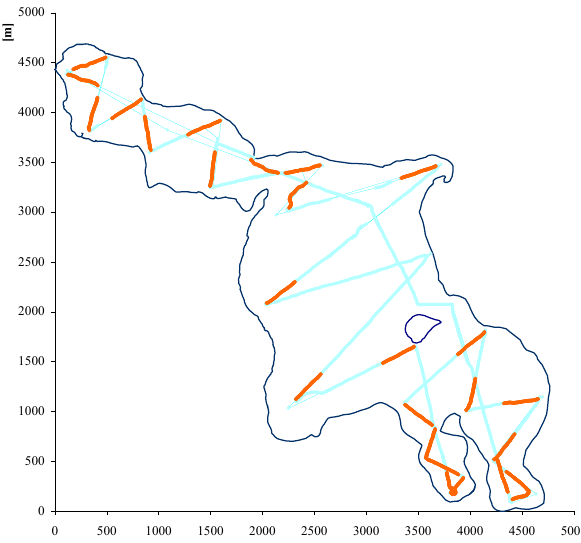
Figure 2. Location map of hydroacoustic survey transects (solid light blue line) in Lake Dejguny (Poland) during September/October 2021. The solid orange line marks the initial fragments of 1000 pings, from which the catch and hydroacoustics data were used in the cross-compliance analysis; detailed explanations can be found in the text (Section 2.2.1).